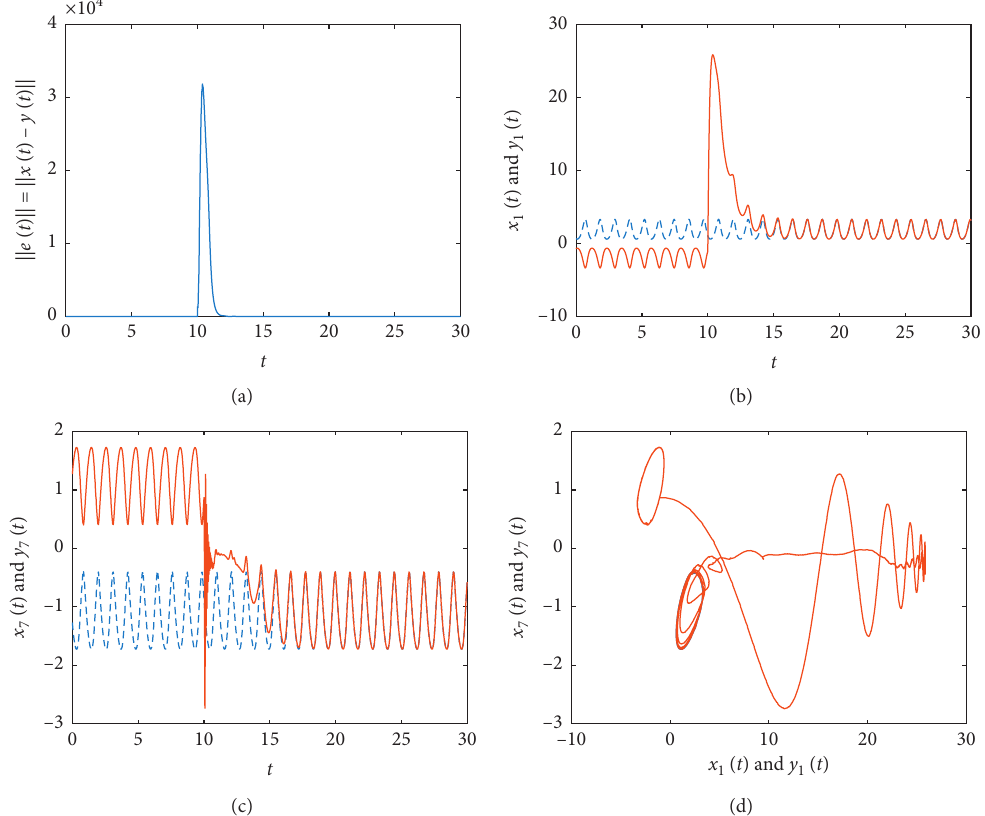
� 24 in the slave system (8) to a e norm of 2 ( t ) and y ( t ) versus time. (d) The states x ( t ) and y ( t ) 7 7 7 7